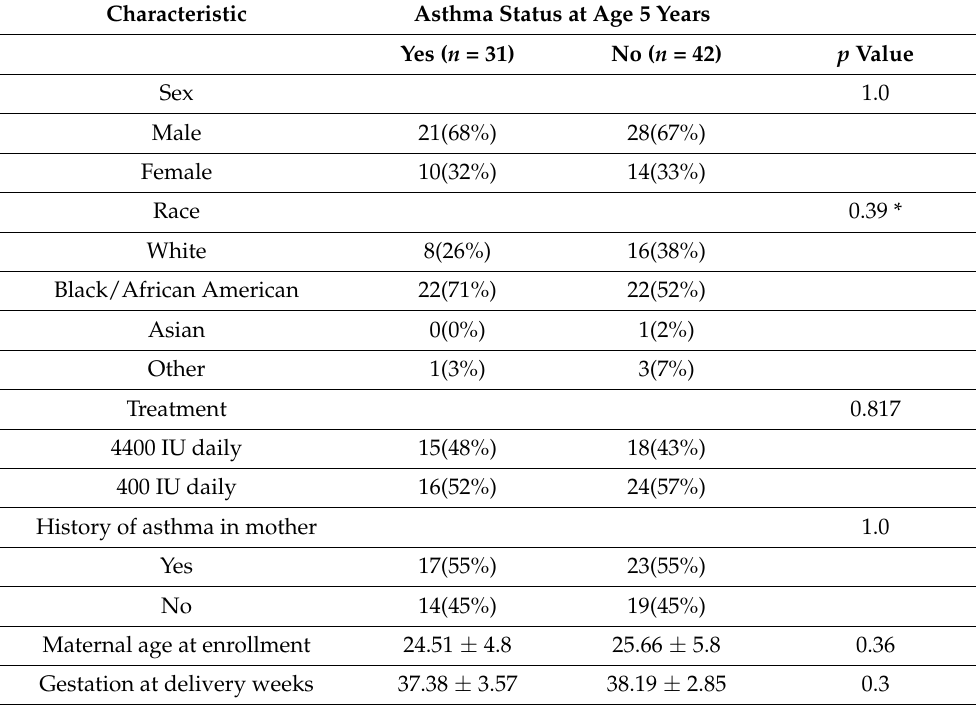
Table 1. Baseline characteristics of the Vitamin D Antenatal Asthma Reduction Trial (VDAART) participants at enrollment according to asthma status at age 5 years.